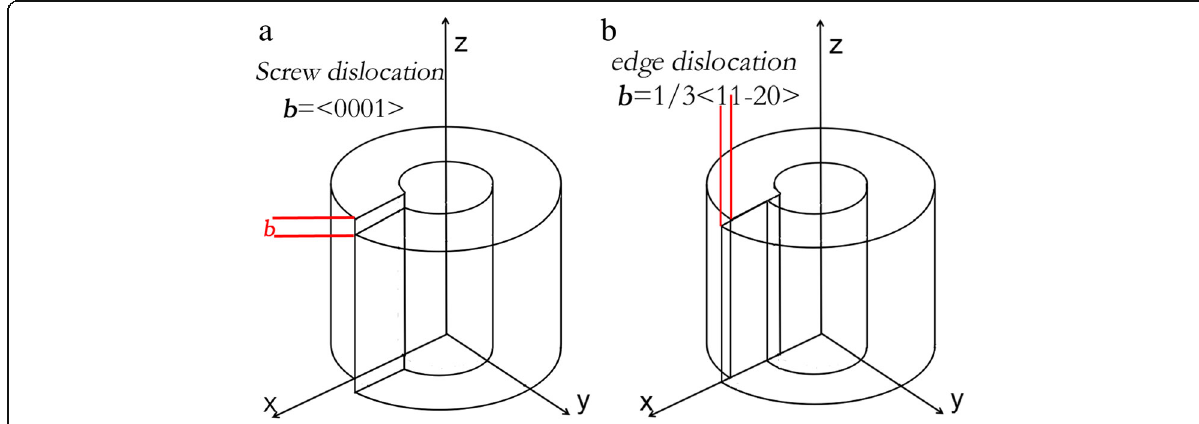
Fig. 3 Cylindrical ring model of a screw dislocation and b edge